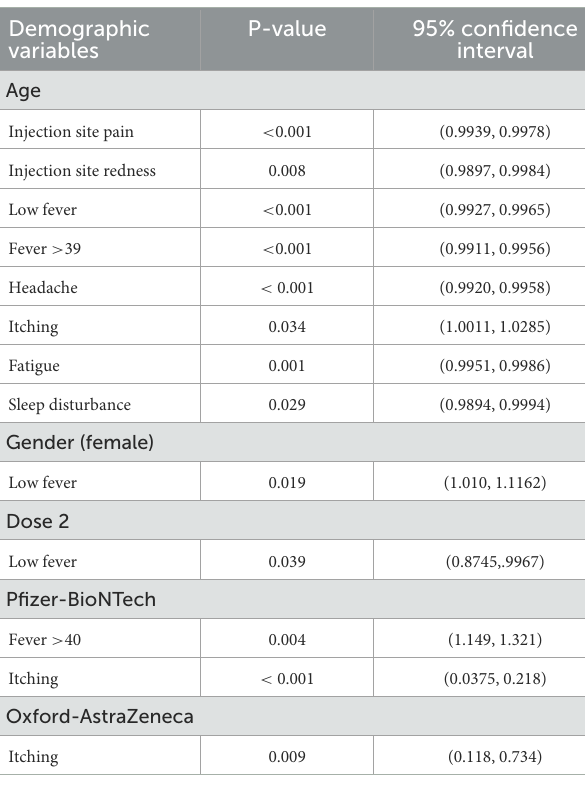
TABLE 4 Logistic regression analysis for associations between vaccine minor and/or major adverse events and demographic